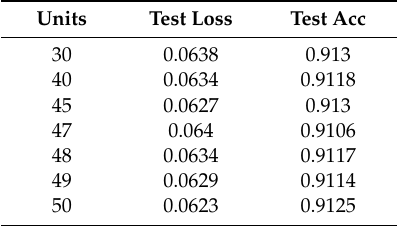
Figure 10. Forecast results of the LSTM model with the four input groups. Table 8. The loss value and accuracy of the LSTM model trained in di ff erent units. Table 7. Forecast results of different input data formats with the LSTM model.